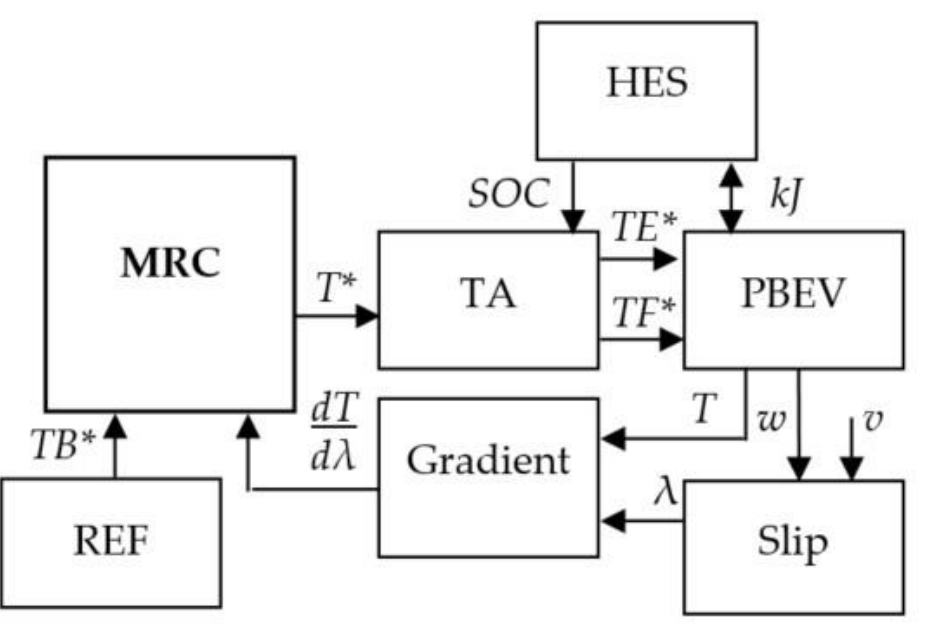
Figure 1. The architecture of the EV braking system.